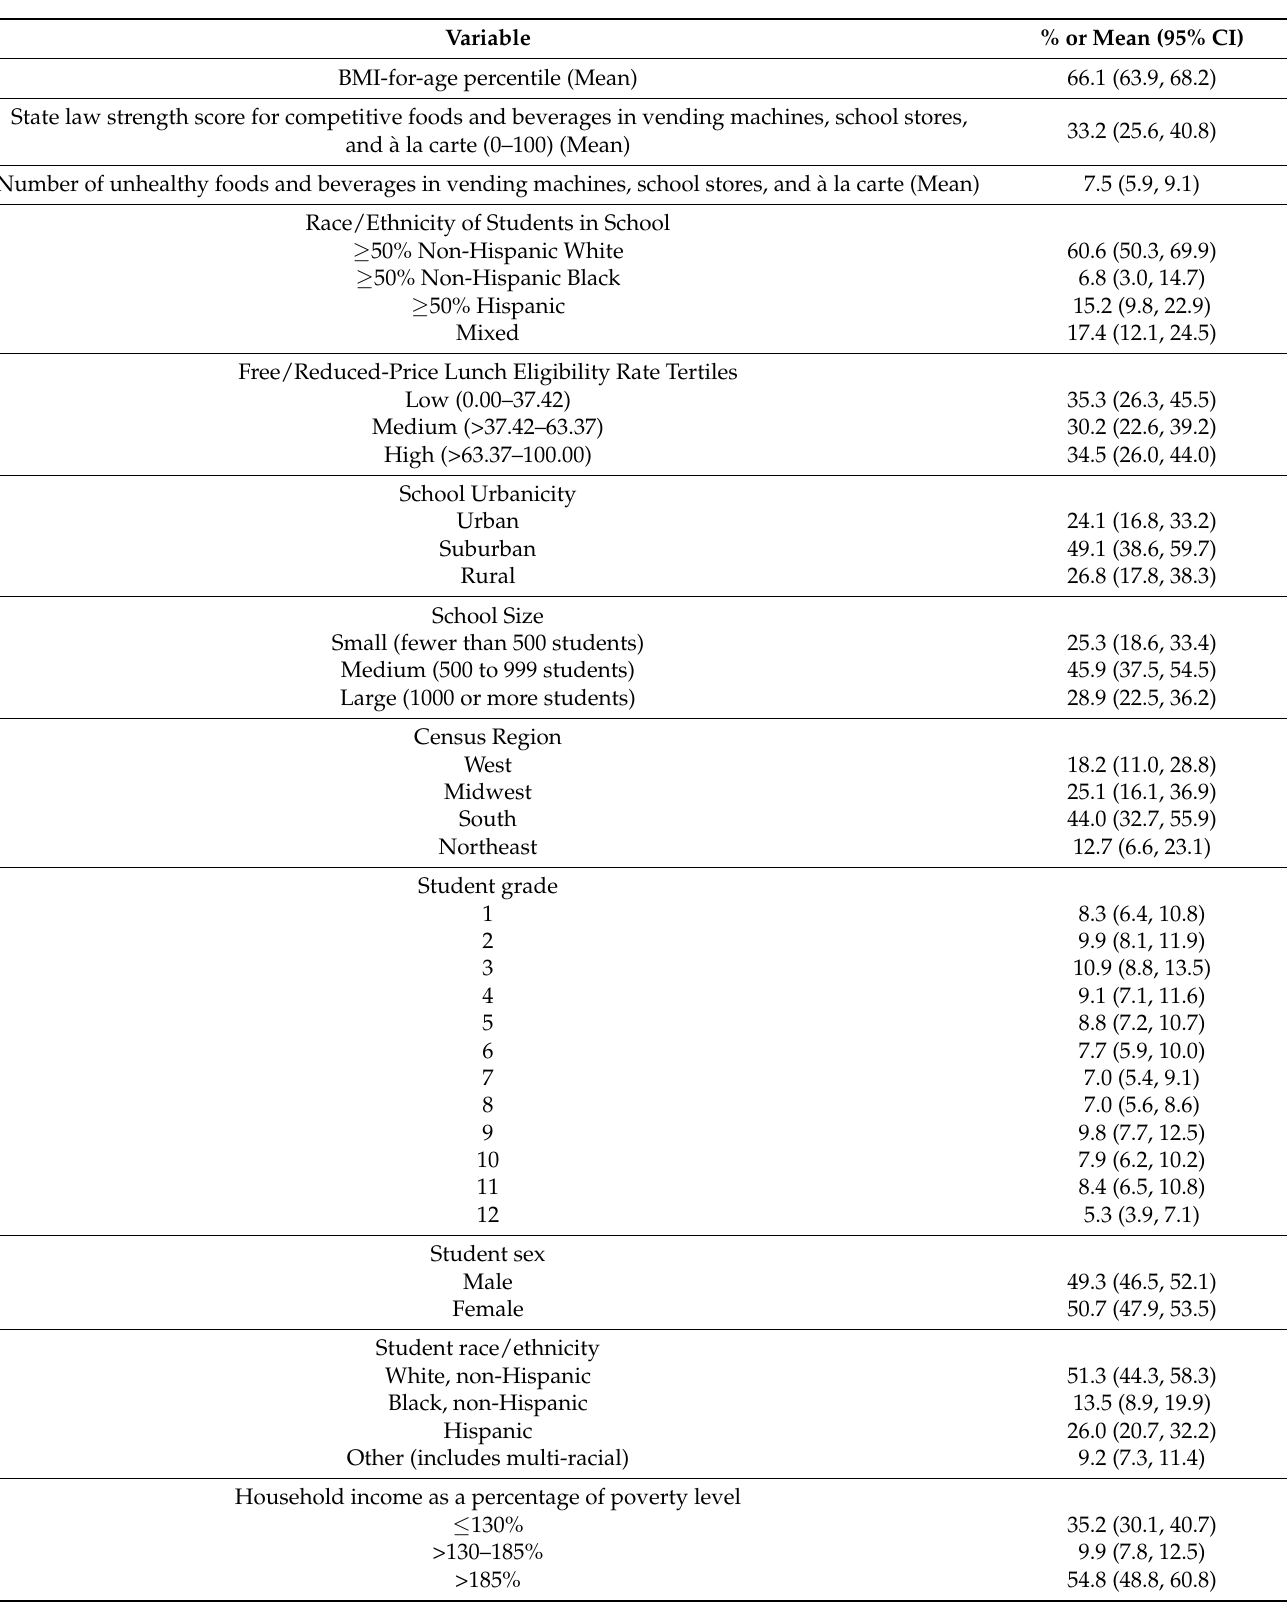
Table 1. Analytic sample